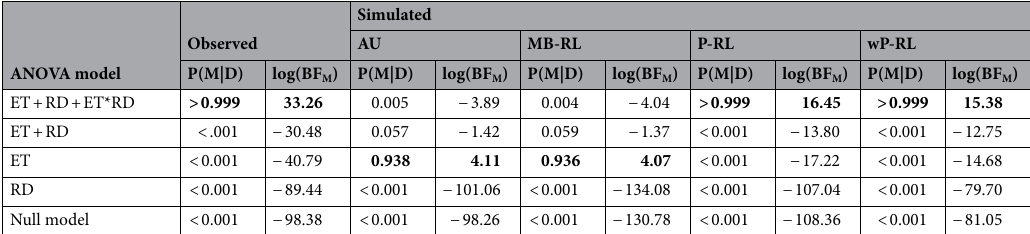
Table 1. Results of Bayesian repeated measures ANOVAs for observed and simulated conditional error probabilities. Most likely ANOVA model given the data in bold. AU attentional-updating model, MB-RL only model-based reinforcement-learning model, P-RL parallel reinforcement-learning model, wP-RL weighted parallel reinforcement-learning model, P ( M|D ) posterior probability of ANOVA model (M) given the data (D), log ( BF M ) logarithmized Bayes factors for any ANOVA model when compared to all the other ANOVA models together, ET factor error type (set-loss vs. perseveration), RD factor response demand (repetitions